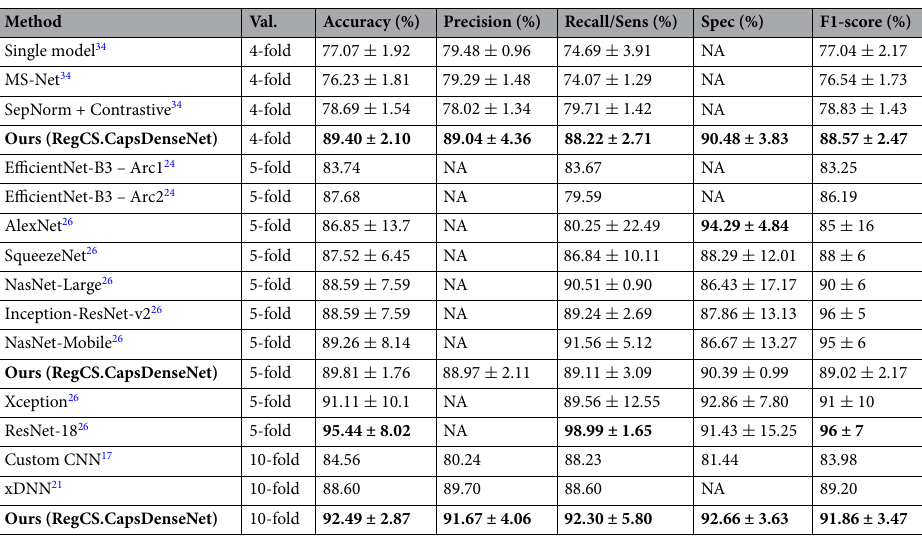
Table 4. Comparison of our proposed RegCS.CapsDenseNet model with related works on COVID-19 dataset with different validations. The highest values in each protocol are shown in bold.